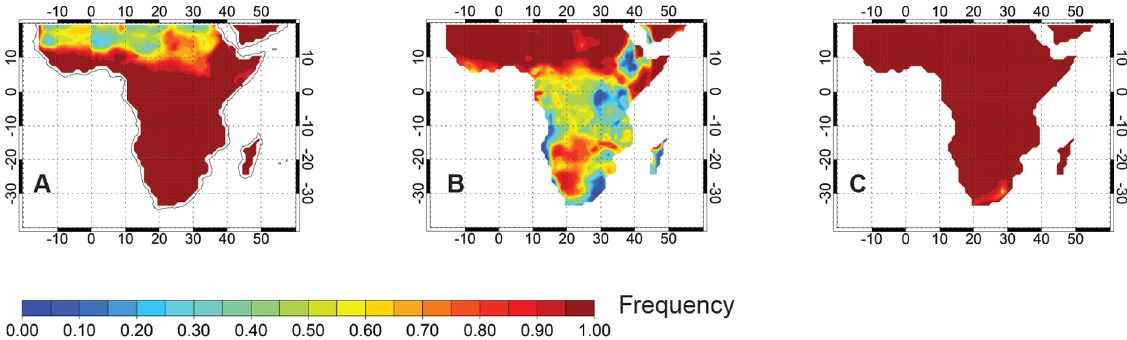
Figure 3. Maps depicting sub Saharan Africa and the frequency (fraction of days) on which mean afternoon (12–18 hr local time) surface air temperatures are below 43 6 C during the warm season (A), exceed 30 6 C in the warm season (B) and are above 10 6 C in the cold season (C).